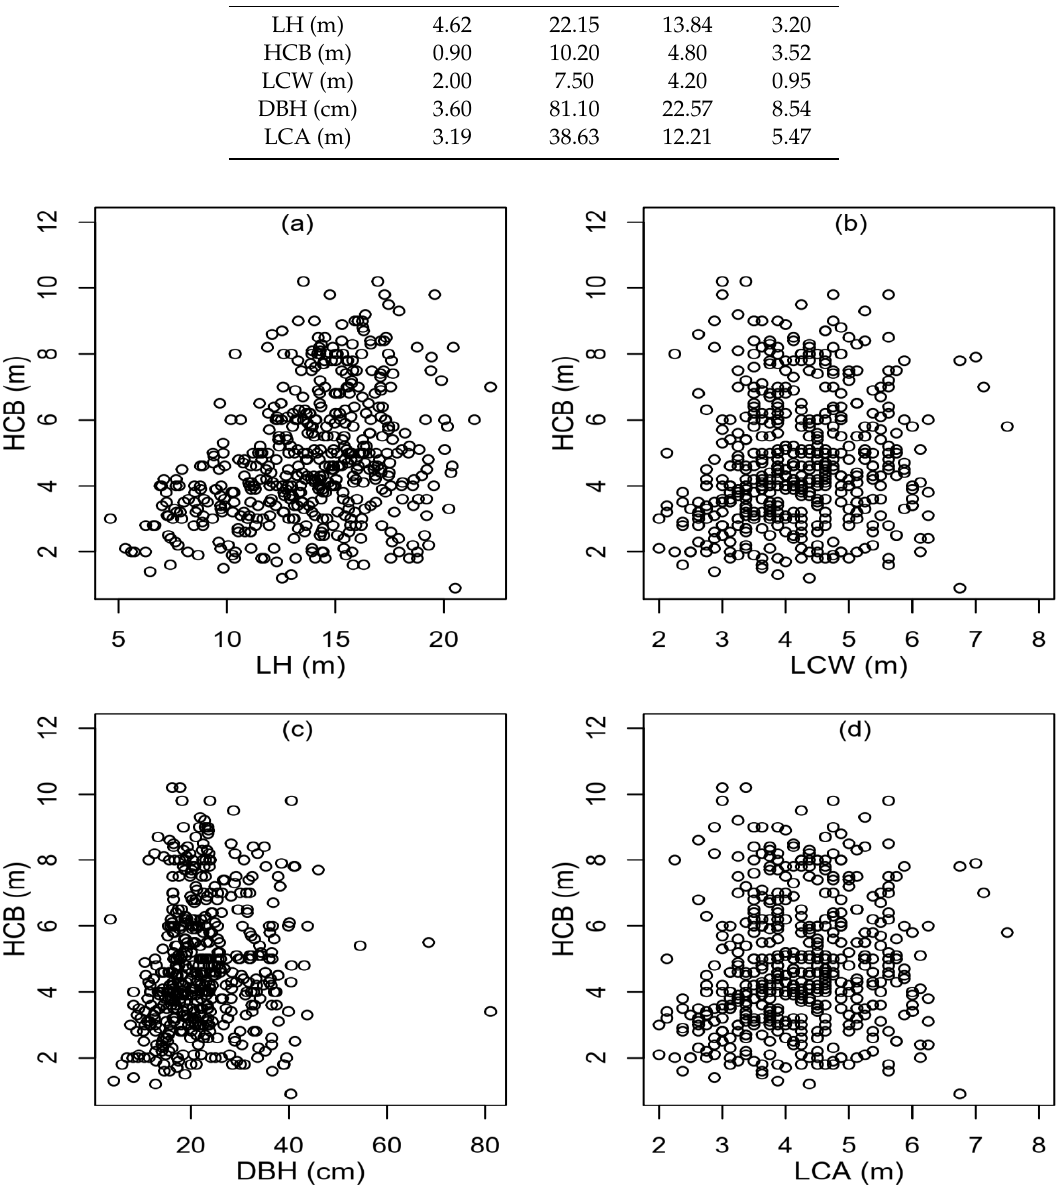
Figure 2. The relationships of height to crown base (HCB) with other tree variables: ( a ) light detection and ranging (LiDAR)-derived tree height (LH), ( b ) crown width (LCW), ( c ) diameter at breast height (DBH), and ( d ) crown projection area (LCA) for Picea crassifolia Kom.